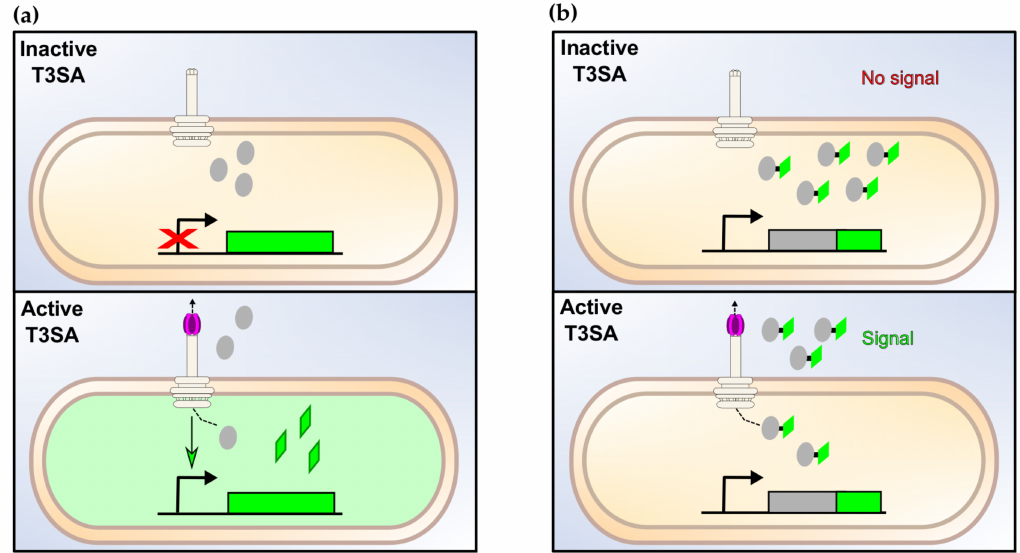
Figure 4. The types of assays to measure the activity of the T3SA. ( a ) Transcription-based assays. The activation of T3SAs upregulate the expression of the reporter gene, thus leading to an increased production of the corresponding assay proteins. The relative secretion activity is then estimated by the measurement of the fluorescence or of any other relevant signal emitted by the assay protein (e.g., luminescence, colorimetric, etc.). ( b ) Secretion-based assay. Upon activation of the T3SA, T3SA substrates fused to a specific tag are secreted. The relative amount and location of the substrates inside host cells or in the extracellular medium are measured with the relevant method, as described in ( a